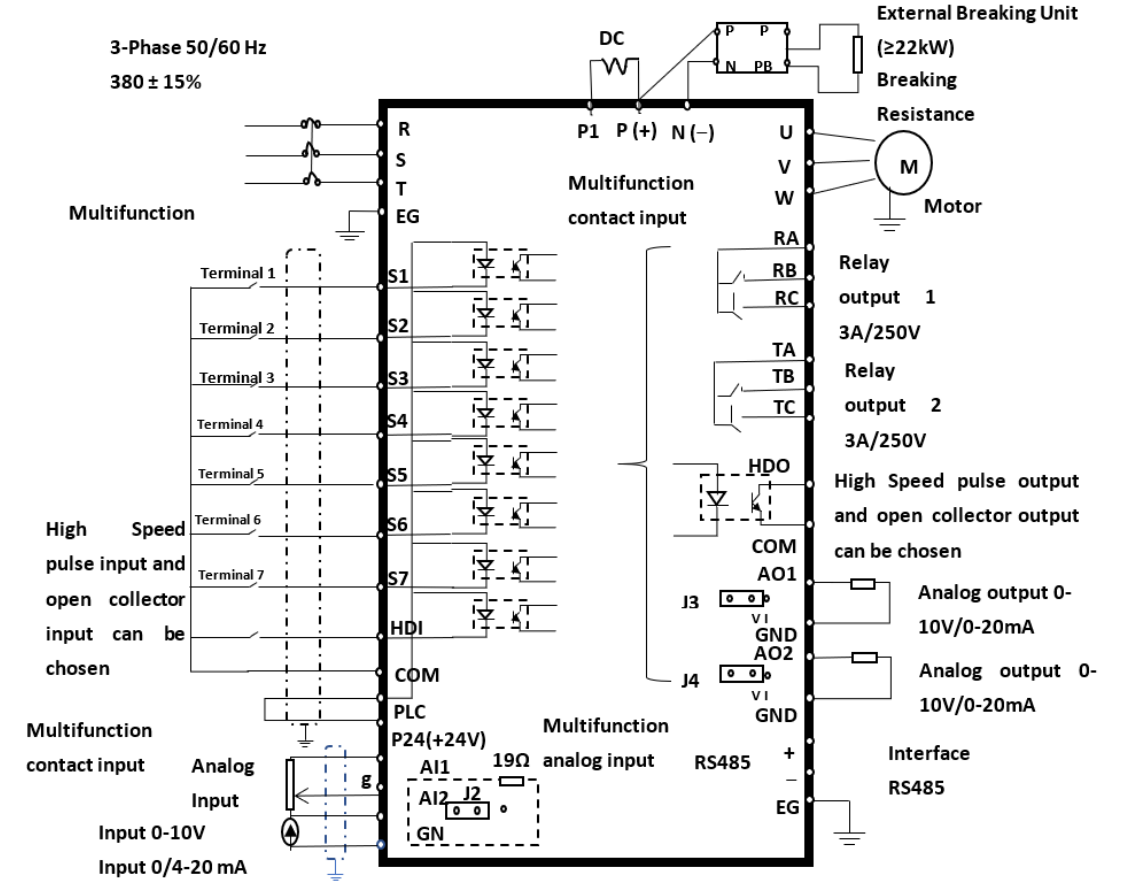
Figure 2. Wiring diagram for the frequency converter.